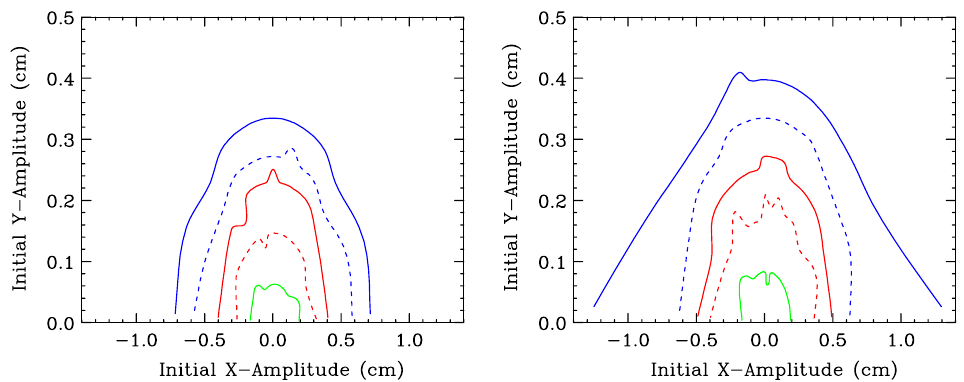
FIG. 10. Momentum dependent dynamic aperture without errors for OPA (left) and 4th-order geometric achromat (right) solutions with chromaticity set to zero, where (cid:8) ¼ 0 (blue solid), 0.5% (blue dashed), 1% (red solid), 1.5% (red dashed), and 2%